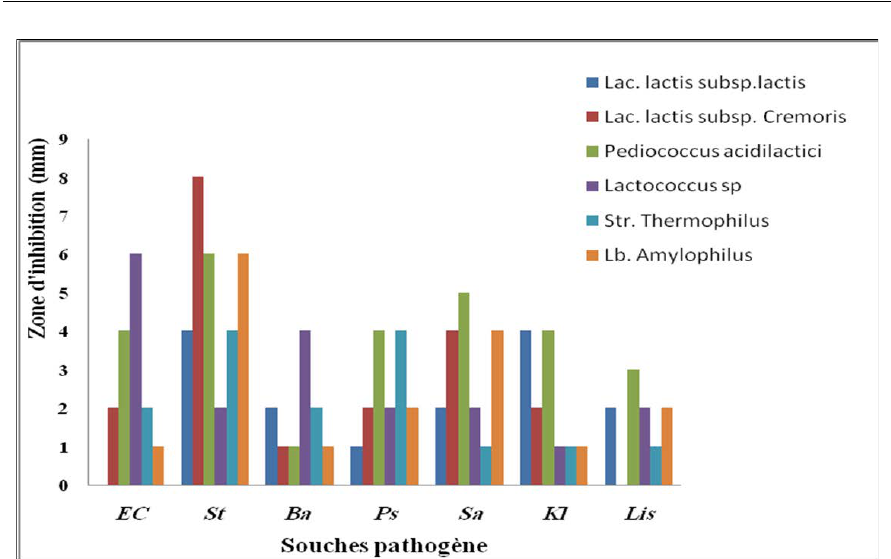
Fig. 4. Effect of producing bacteriocin by lactic acid bacteria against pathogenic strains